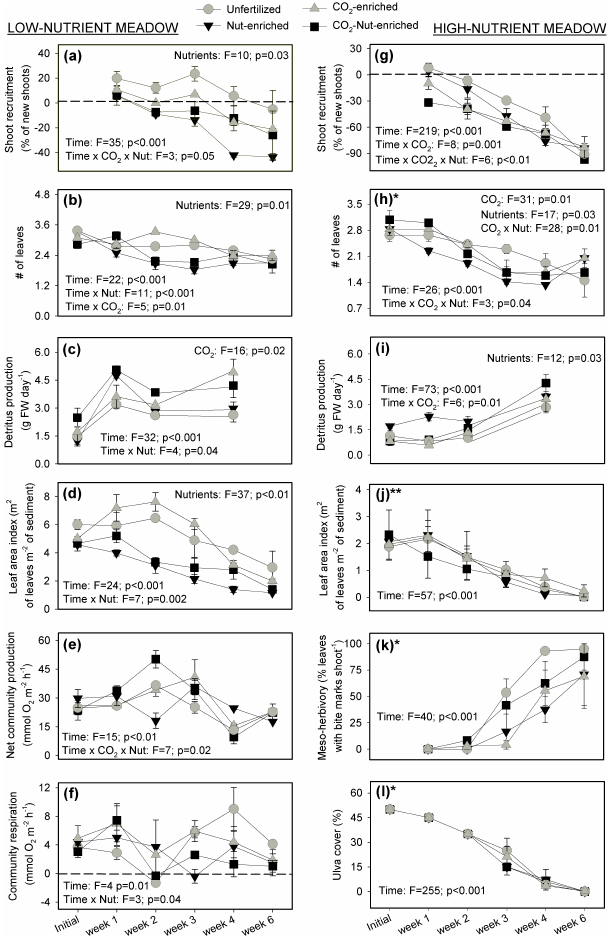
Figure 1. Effects of CO 2 and nutrient additions on Zostera noltii plant-, community-, and ecosystem-level traits from the low- nutrient (left graphs) and high-nutrient meadow (right graphs) through time. Symbols are means ( ± SE, n = 2). F statistics and p levels from RM ANOVA tests are shown for among-subject factors (CO 2 ; Nut: nutrients) and their interaction (CO 2 × Nut), and for within-subject factor (Time) and interactions (Time × CO 2 , Time × Nut, Time × CO 2 × Nut). Only the significant effects ( p <0.05) and useful traits for results interpretation are shown here; the non-significant effects are shown in Sect. S3 (in the Supplement). ∗ Variables that did not meet normality after trans- formation, for which the significance level was more restrictive ( p <0.03) to minimize the possibility of Type I error. ∗∗ Variable sqrt-transformed to meet